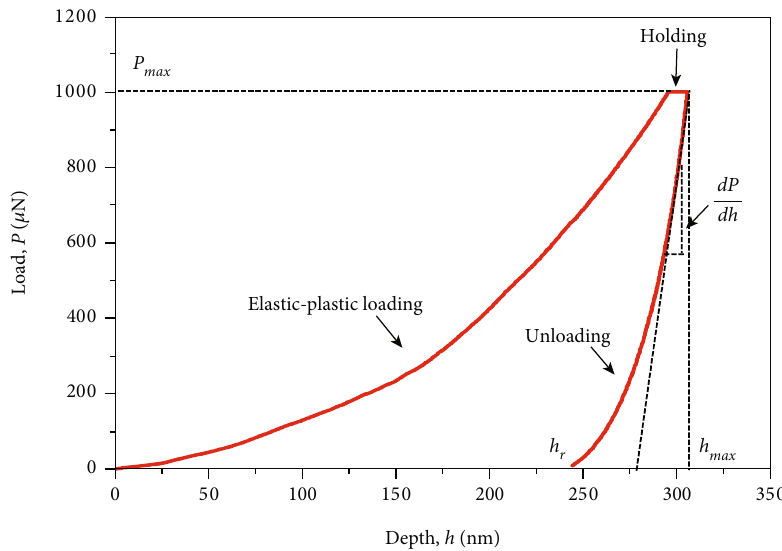
Figure 1: Typical load-depth curve obtained from nanoindentation.